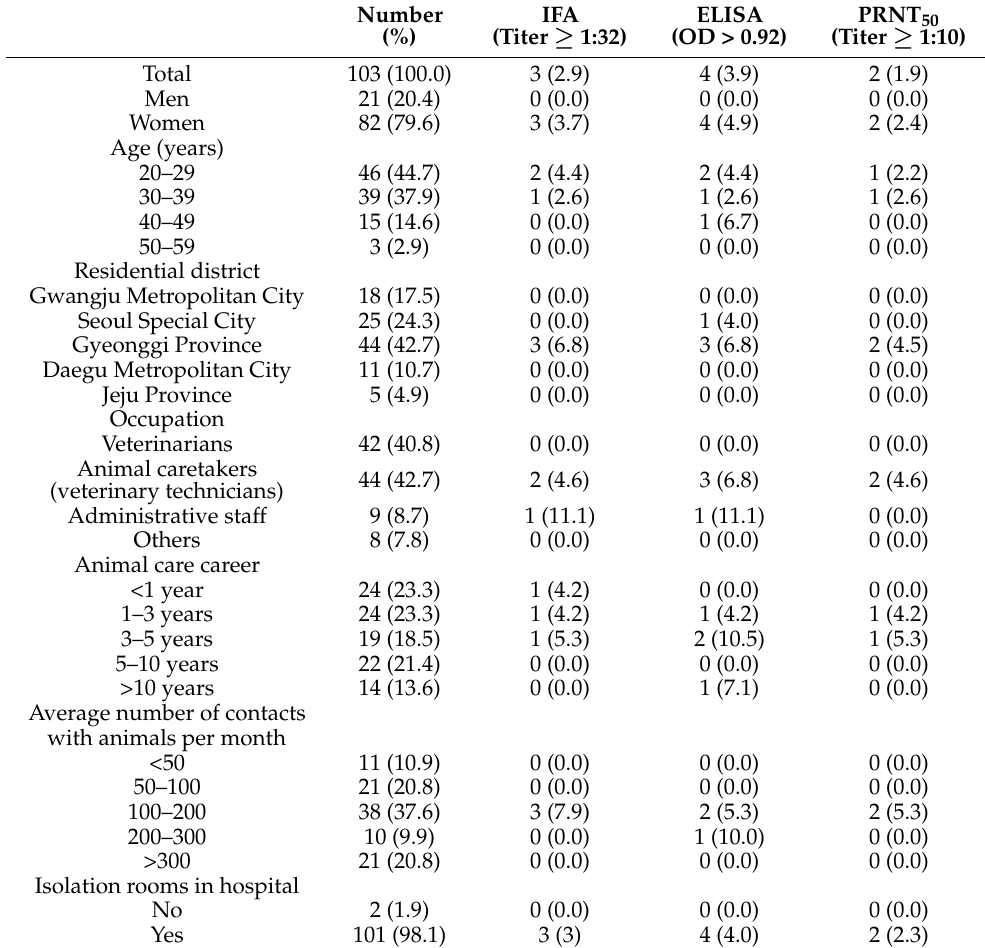
Table 1. Demographic characteristics and seroprevalence of SFTSV antibodies in the study partici- pants ( n = 103).